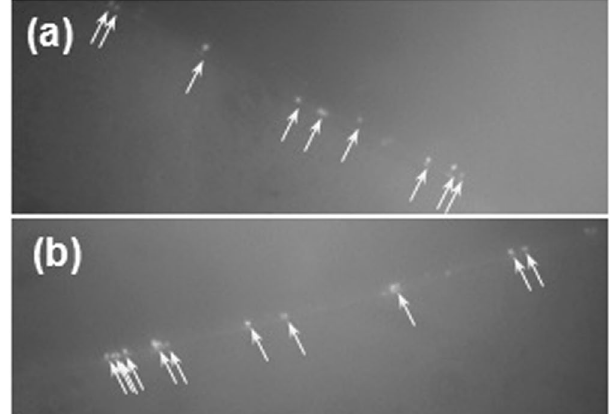
Figure 6. Confirmation of bacterial capturing by fluorescence imaging on detached bacteria ( a ) Fluorescence images of detached S . aureus by Pluriselect (neutral pH) detachment buffer, ( b ) Detached by IgG elution buffer from Thermo Fisher Scientific (pH 2.8), both stained with syto 64 dye. Bacteria were observed at the edge of the droplet (marked by